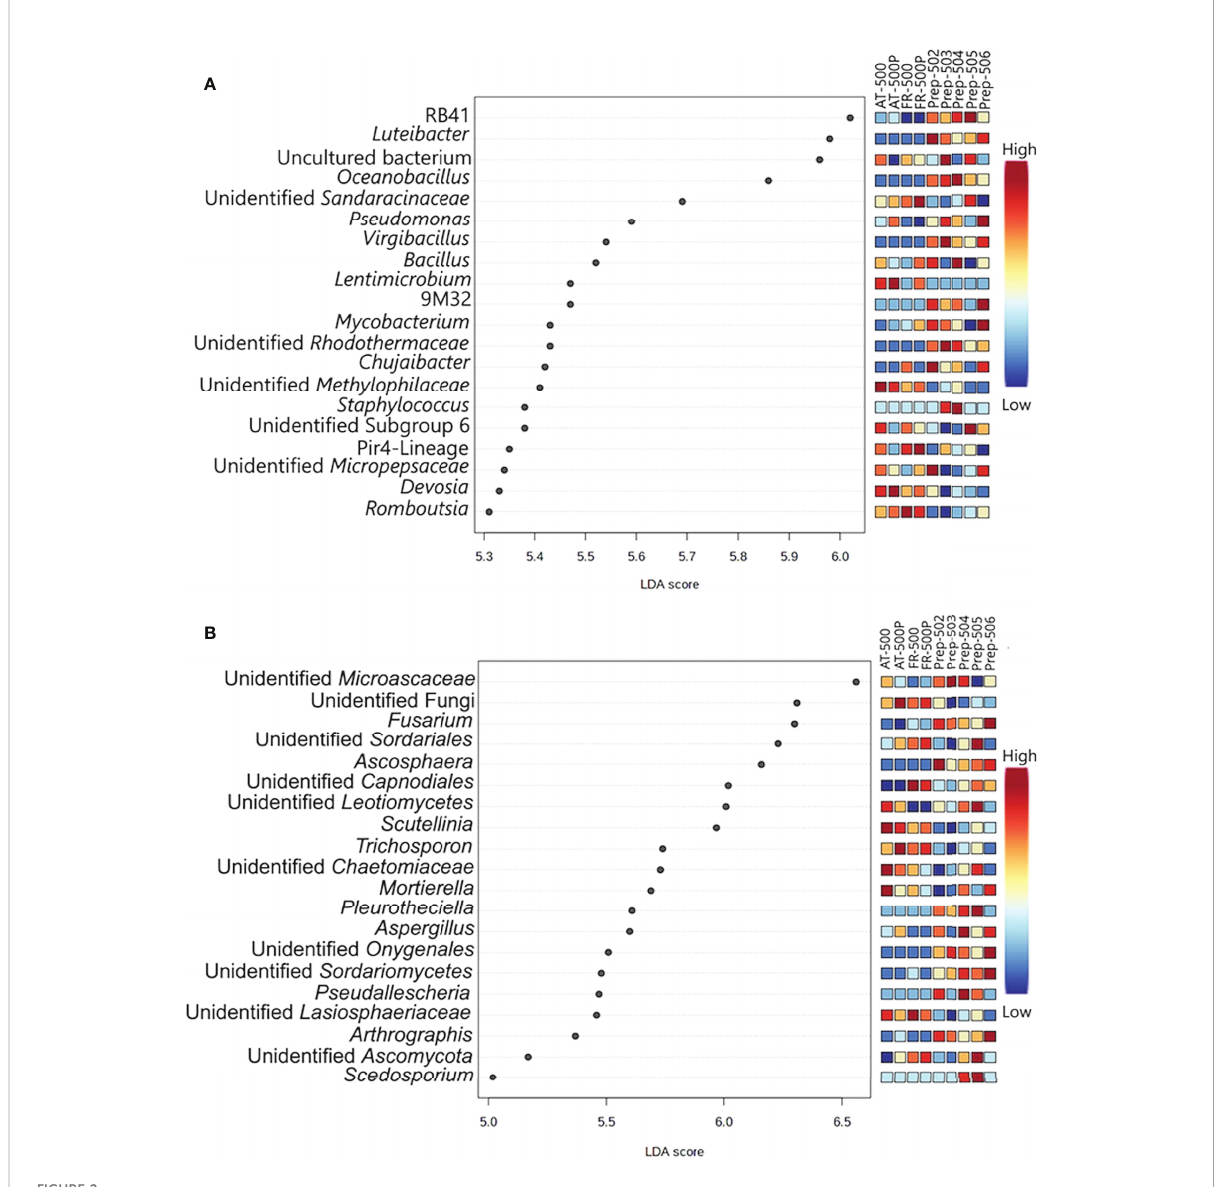
FIGURE 2 Dot plot representation of differentially abundant bacterial (A) and fungal (B) genera between BD manures and BD plant preparations. Plant preparations are shown as P-502, P-503, P-504, P-505, and P-506; while biodynamic manures were represented as AT -500/P and FR-500/P. Acronym P- represent preparation, while AT and FR represent the countries Austria and France where the BD manures were produced. The differentially abundant genera with LDA scores between 5 and 7 and were based on FDR adjusted P-value. The coloured bar represents the relative abundances of the differentially abundant genera, with the lowest indicated as blue and highest as